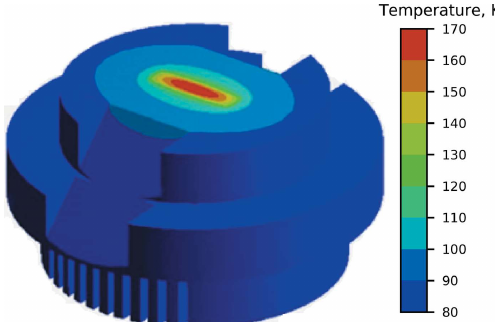
Figure 2 Design of the ISS DCM first crystal along with the finite element analysis of the temperature distribution during normal operations. The top of the crystal is the diffracting surface, while the back of the crystal contains the channels used for the LN 2 cooling. The temperature map is given for the maximum heat load of 2.2 kW.